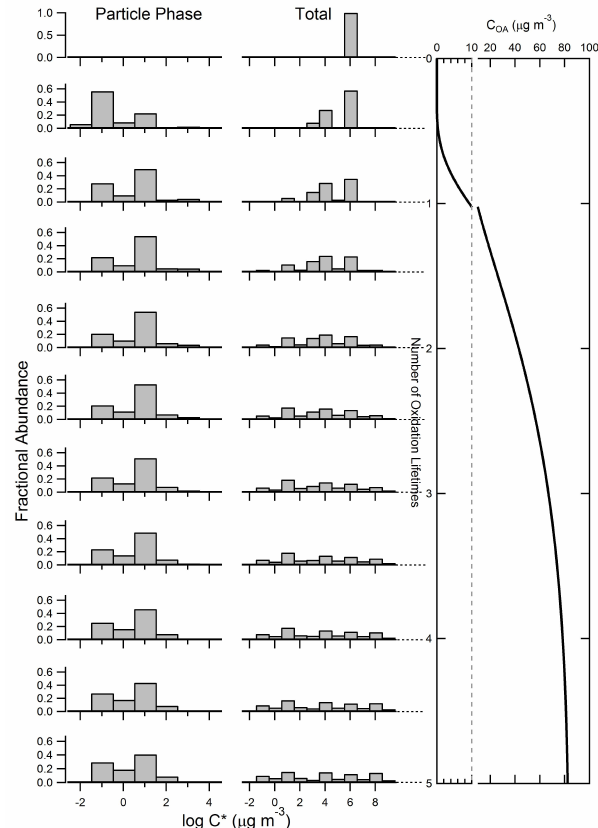
Fig. 6. Histograms showing the variation in the particle phase and total mass distributions when binned into logarithmically-spaced volatility bins, as a function of the number of oxidation lifetimes. Calculations are for a N C = 12 SOA precursor, including fragmen- tation. For reference, the variation in the C OA with lifetimes is